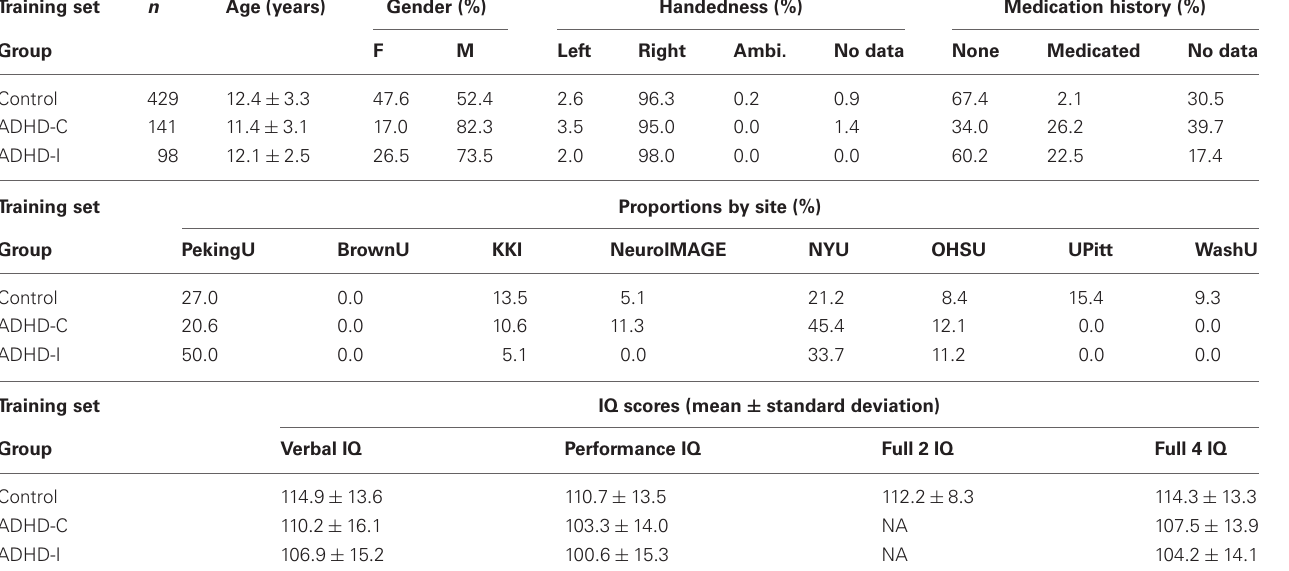
Table 1 | Details of Training Dataset participants. Training